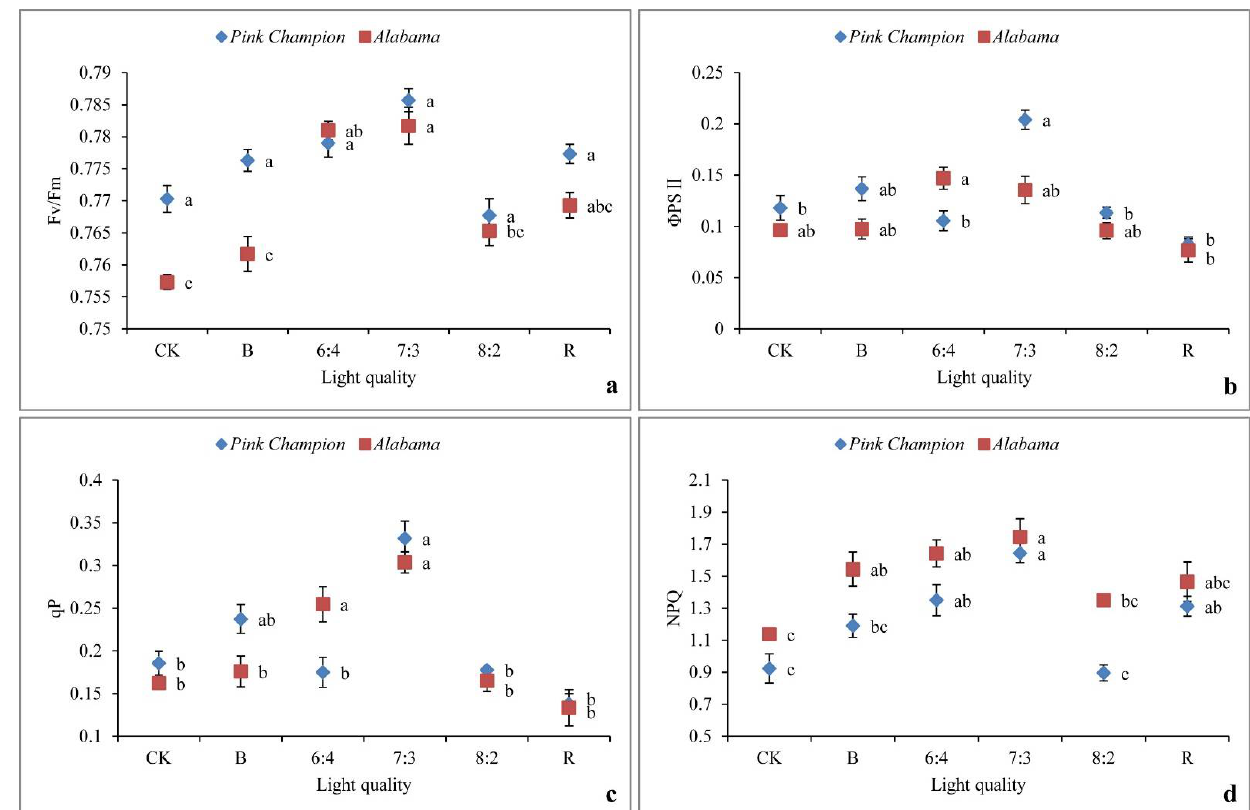
Figure 4. Effects of different light qualities on chlorophyll fluorescence parameters of Spathiphyllum Anthurium ‘Pink Champion, Alabama’ (( a ) Fv/Fm, ( b ) ФPSII, ( c ) qP, ( d ) NPQ.). The statistical analysis has been carried out separately for each cultivar. Vertical bars indicate standard error ( n = 5). Different letters represent a significant difference at p < 0.05 among treatments by the Duncan’s multiple range test.